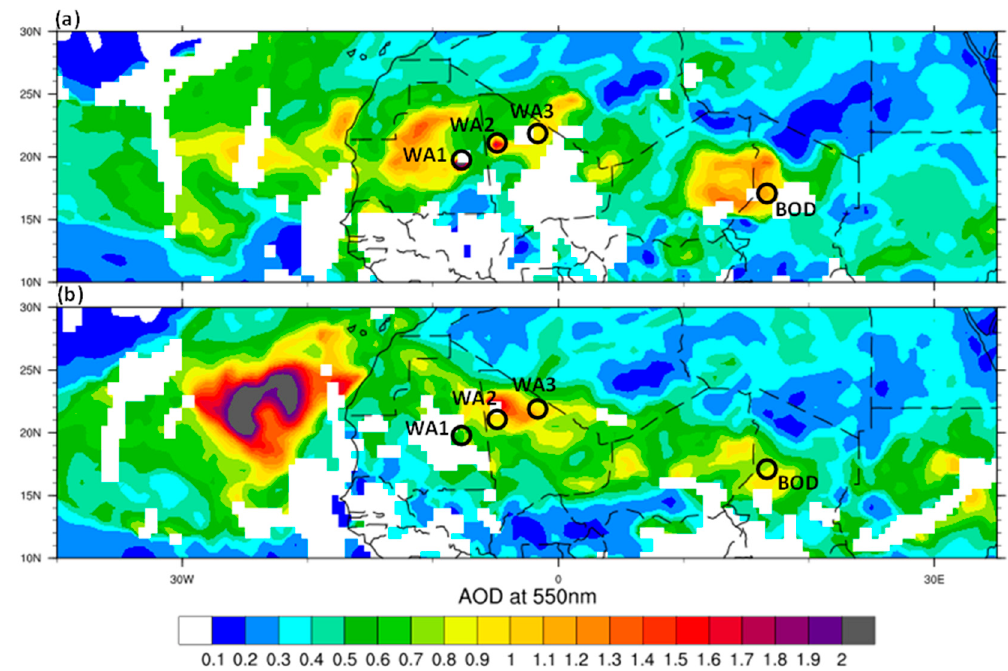
Figure 2. ( a ) Aerosol optical depth (AOD) patterns for 3 September 2005, and for ( b ) 4 September 2005 (bottom), which is the same day as the visible image shown in Figure 1. Also shown are the major dust source regions, termed “hot spots” by Engelstaedter and Washington [14]; three are located over West Africa, denoted by WA1, WA2 and WA3, and one is located over the Bodélé Depression in Chad, denoted by BOD. We constructed the AOD patterns by fusing data from the Moderate-Resolution Imaging Spectroradiometer (MODIS) instrument onboard the Aqua and Terra satellites. Note: Satellite-derived AOD measurements are often underestimated over deserts [ 29].